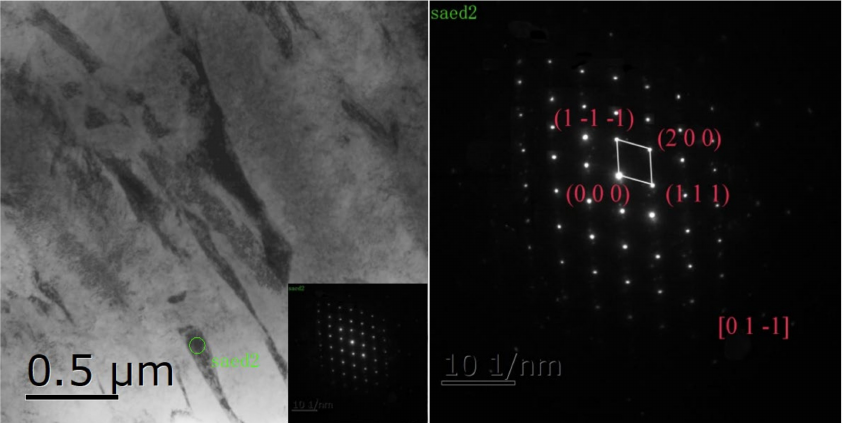
Figure 12. Representative TEM image of austenite and corresponding diffraction pattern.